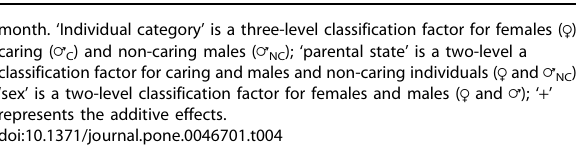
Table 4. Summary of the step-down model selection procedure for the capture-recapture analysis that investigated the influence of time, sex, parental state, and individual category on the transition probabilities between